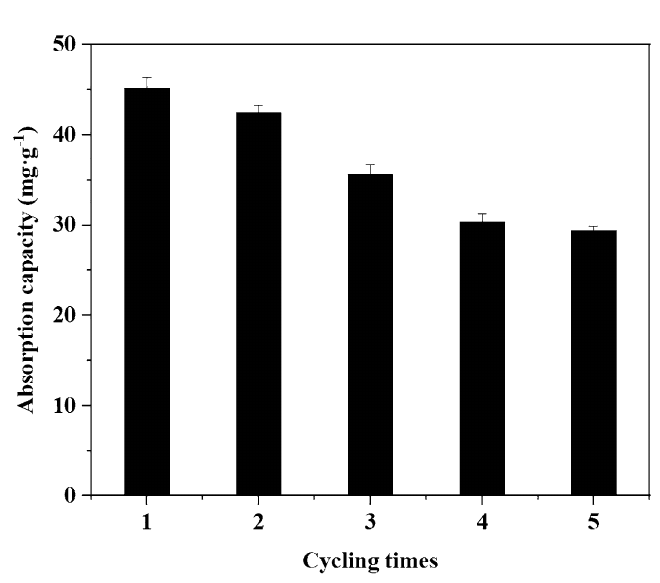
Figure 15. Adsorption capacity at different adsorption–desorption